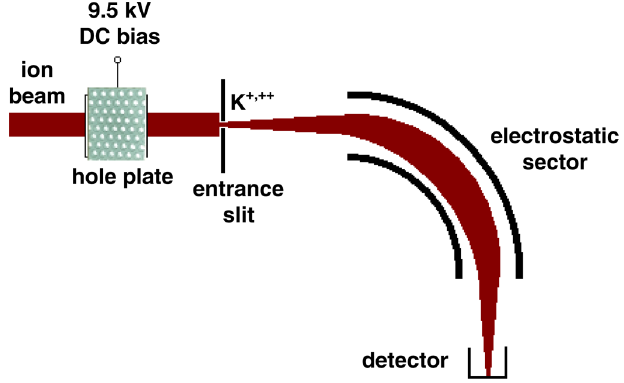
FIG. 3. (Color) Simplified schematic diagram of the electrostatic energy analyzer.